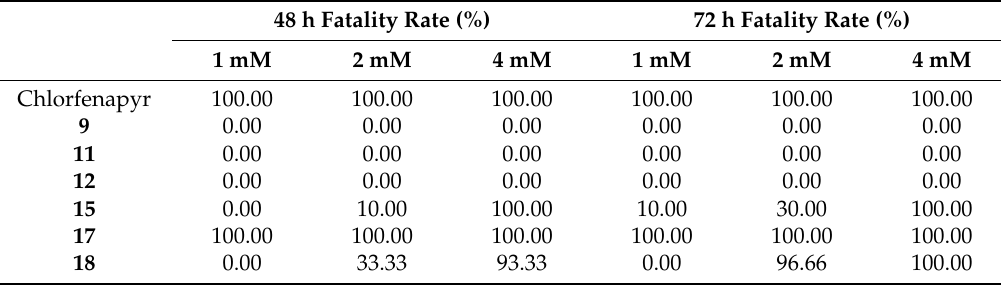
Table 3. The fatality rates of tralopyril, 9 , 11 , 12 , 15 , 17 and 1 8 against P. xylostella. 48 h Fatality Rate